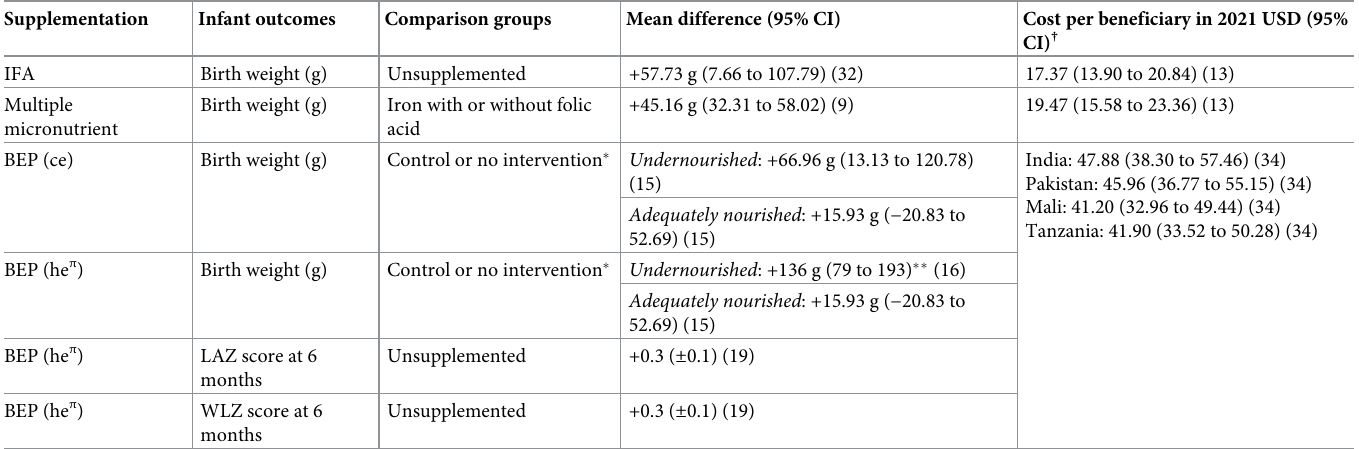
Table 2. Effects of different maternal intervention on birth weight and 6-month child growth